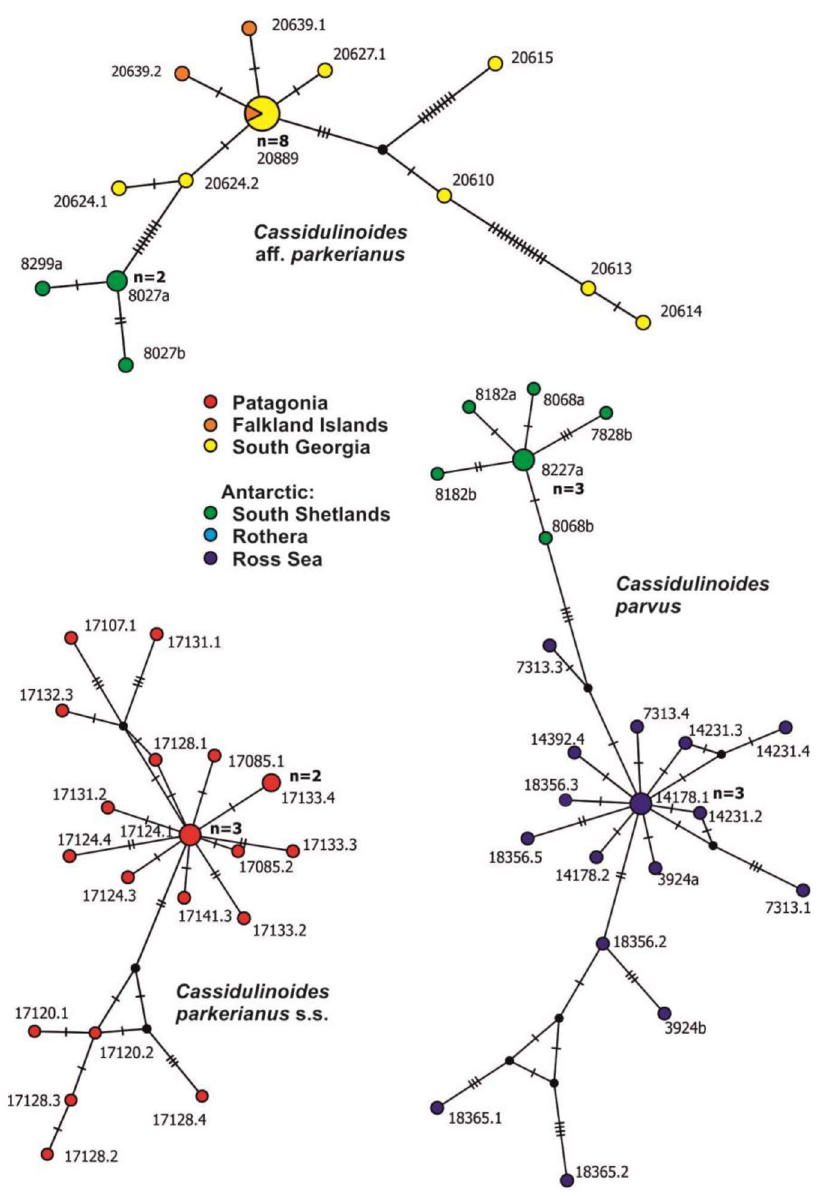
represent different